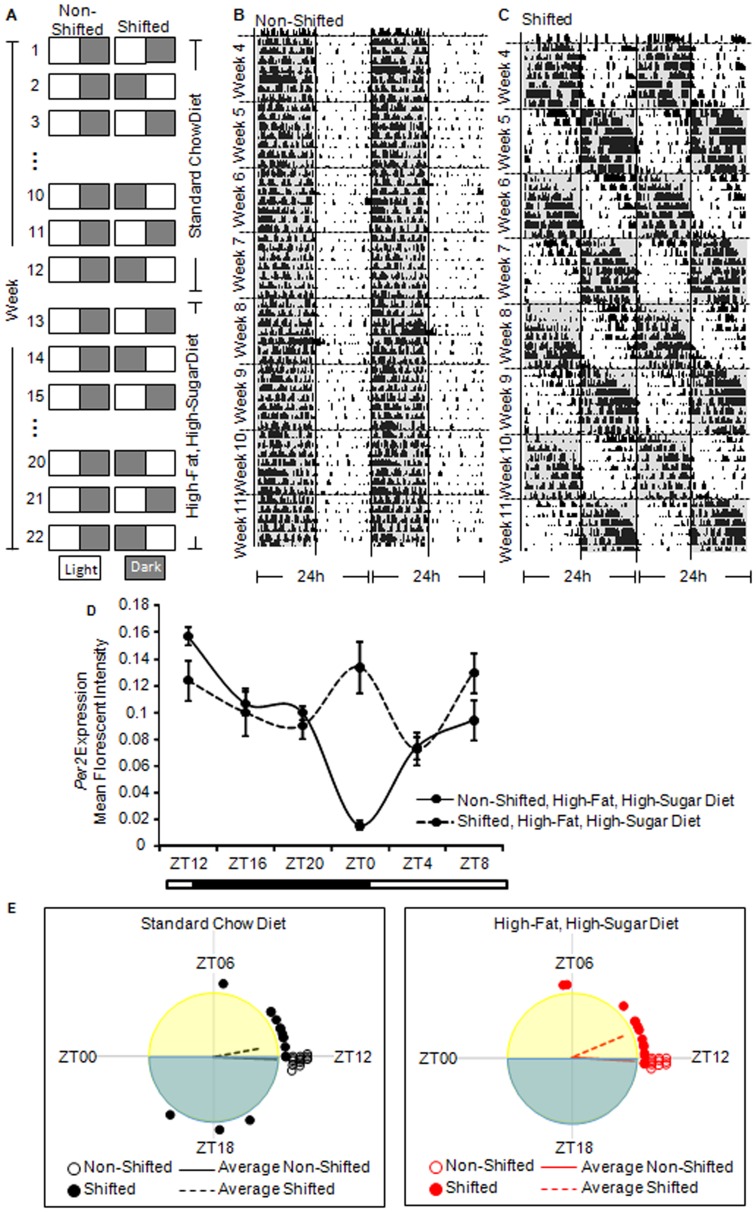
Protocol and timeline for circadian disruption, dietary changes, and stool collection.A. Non-shifted mice were kept on a constant light:dark schedule for the entirety of the experiment whereas Shifted mice underwent once weekly light:dark inversion. Mice were maintained on a standard chow diet for the first 12 weeks of the study followed by a stool collection at the end of week 12. Mice were subsequently placed on a high-fat, high-sugar diet for 10 weeks and stool was collected at the end Week 22. Representative behavioral activity recording for a Non-shifted (B) and Shifted mouse (C). Activity is represented as dark areas in the actogram. These data demonstrate that non-shifted mice have stable behavioral patterns while the shifted mice have disrupted behavioral patterns. D. Expression of Per2 mRNA in the proximal colon one day after the week 22 stool collection demonstrates altered circadian expression in the intestine following the 22 weeks of phase shifting. Significant effect of light condition, (F(1,58) = 5.84, p = 0.02), Zeitgeber Time (ZT) (F(5,58) = 8.38, p<0.0001), and light condition x ZT interaction (F(5,58) = 9.67, p = <0.0001). E. Activity onset phase distribution on the day of stool collection for standard chow-fed and (left) and high-fat, high-sugar diet (right). Individual mouse onset times relative to the light:dark cycle are depicted by the circles, and vector means depicted by the lines. There were no significant differences between the mean phase angle of entrainment between the shifted and non-shifted mice at the time of stool sample collection, but shifted mice exhibited a greater dispersal of phases in both diets (p<0.05).